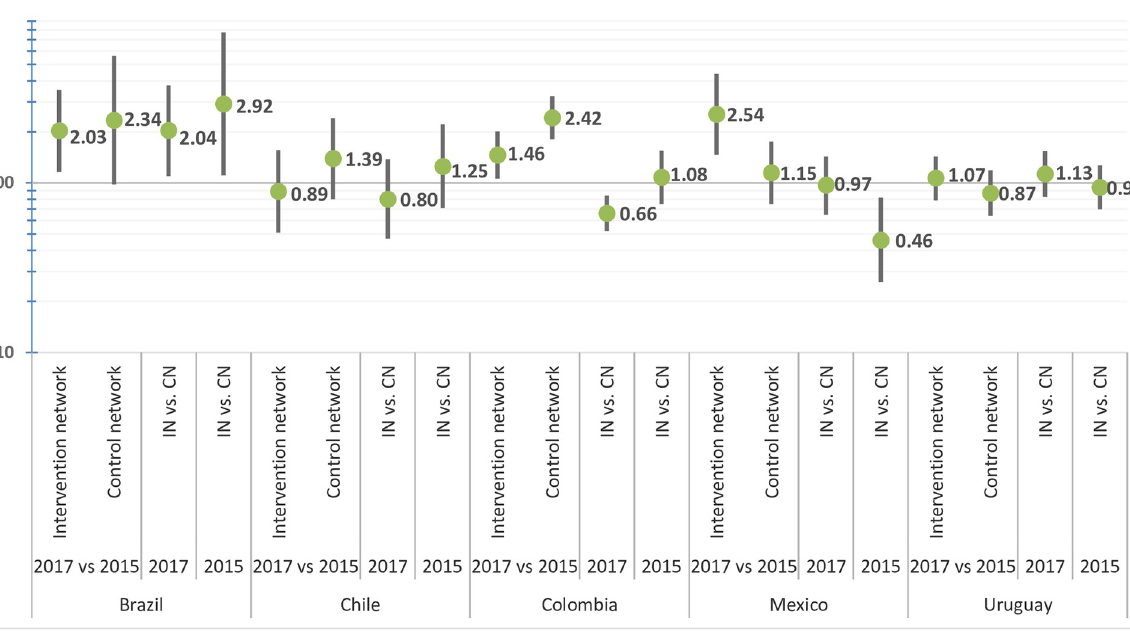
PLOS ONE | https://doi.org/10.1371/journal.pone.0261604 January 12,